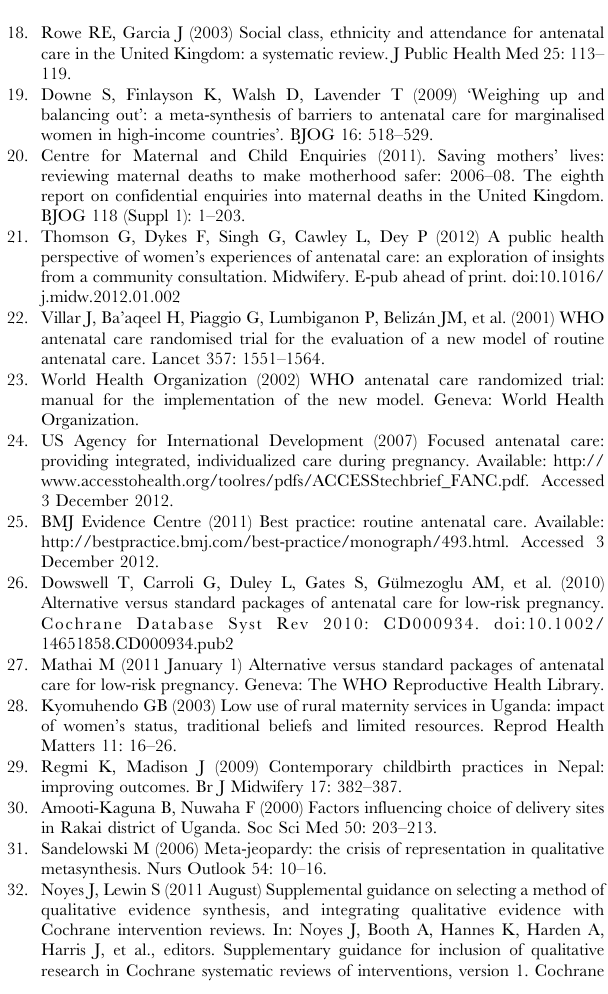
Table S1 Assessment of quality of included